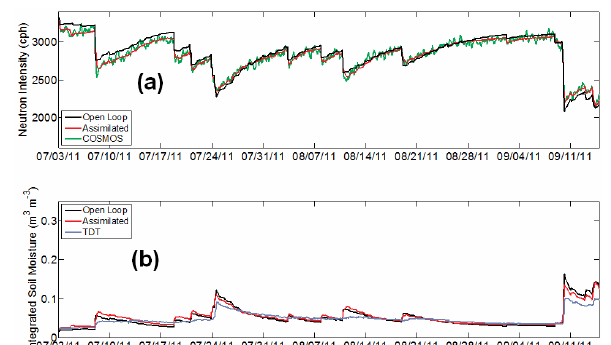
Fig. 9. Application of the COSMIC model to assimilate COSMOS probe counts into the Noah land surface model at the Santa Rita Range field site. The insert in (a) shows the Cumulative Distribution Function (CDF) of neutron counts measured by the COSMOS probe (COSMOS-real, blue), computed by COSMIC from the measured area-average TDT profile (TDT-derived, shown in purple), computed by COSMIC from soil moisture profiles simulated by the (uncalibrated) Noah LSM, and from the COSMOS observations after they have been scaled by CDF matching (NOAH-COSMOS-scaled, shown in green). (a) Time series of the resulting scaled version of the observed neutron count (green) together with the neutron count (calculated by COSMIC) from the soil moisture profiles simulated by the Noah model when running open loop (black) and with the assimilation of COSMOS data (red). (b) shows the depth-average soil moisture for the Noah model when running open loop (black) and with the assimilation of COSMOS data (red) together with the area-average soil moisture measured by the TDT network (purple). To enhance consistency between the three depth averages in (b) they are all weighted by the relative contribution to the above ground fast neutron flux for each level (calculated by COSMIC).